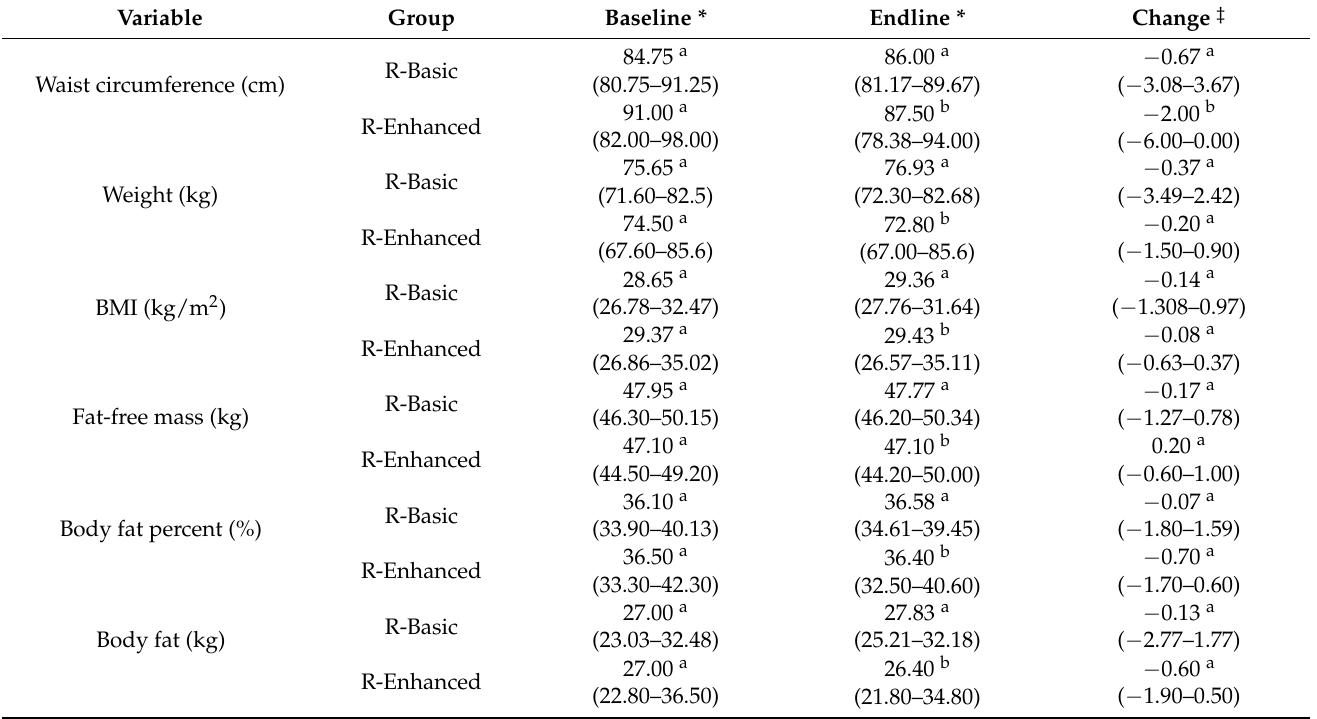
Values are presented as median (25–75%). * Statistical comparisons between baseline and endline scores were performed using Wilcoxon signed-rank test. ‡ Statistical comparisons of difference in change between R-Basic and R-Enhanced were performed using Mann–Whitney U test. Different superscripts indicate significant differences ( p <